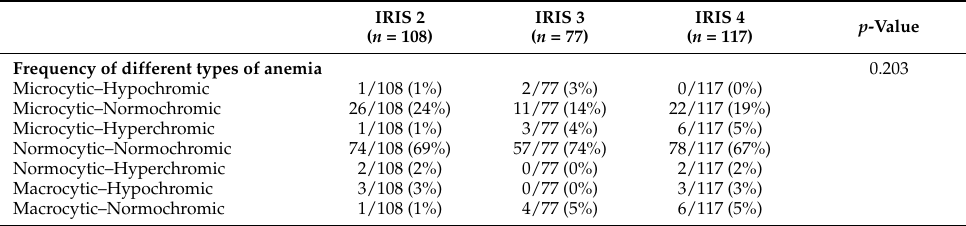
Table 1. Chi squared comparison of different types of anemia among dogs at different CKD IRIS stages.